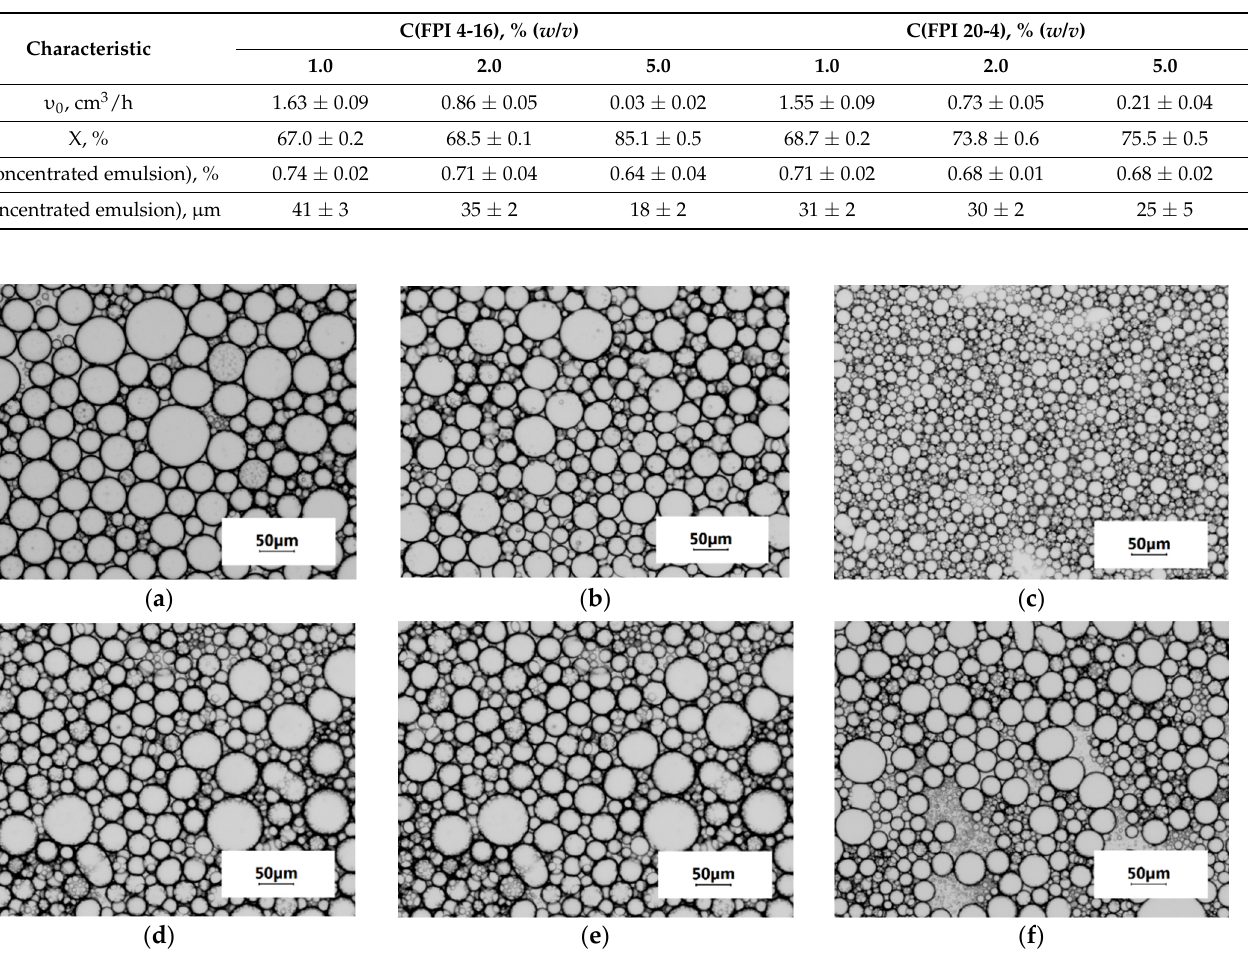
( b ) Figure 6. Droplet size distribution for concentrated emulsions stabilised with FPI 20-4 ( a ) and FPI 4-16 ( b ). C(FPI), % ( w / v ): 1—1.0; 2—2.0; and 3—5.0. With an increase in the concentration of the stabiliser FPI 4-16 or FPI 20-4, an increase in the emulsifying ability was observed, which correlates with an increase in the disper- sion of the emulsions (see Table 4), confirming the well-known pattern [38]. FPI 4-16 and FPI 20-4 demonstrated very similar values of their emulsifying ability at the same concen- tration, which is probably due to the same solubility [39] of these protein isolates (see Figure 4).